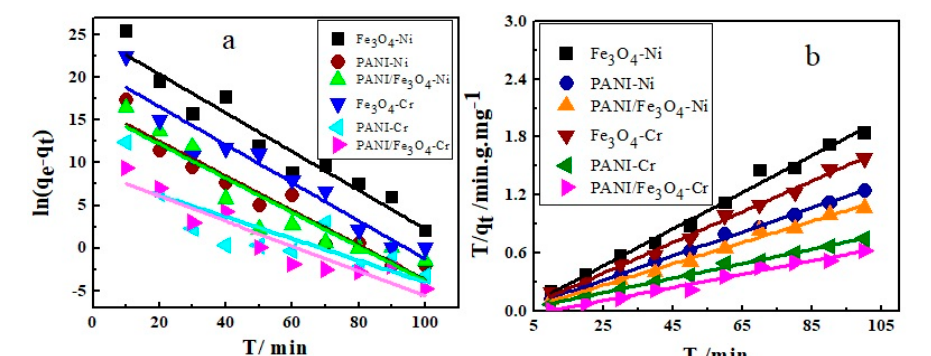
Figure 10. Kinetics of Cr(VI) and Ni(II) adsorption on Fe3O4, PANI, and PANI/Fe3O4 composites ( a ) first order and ( b ) second order kinetics model.